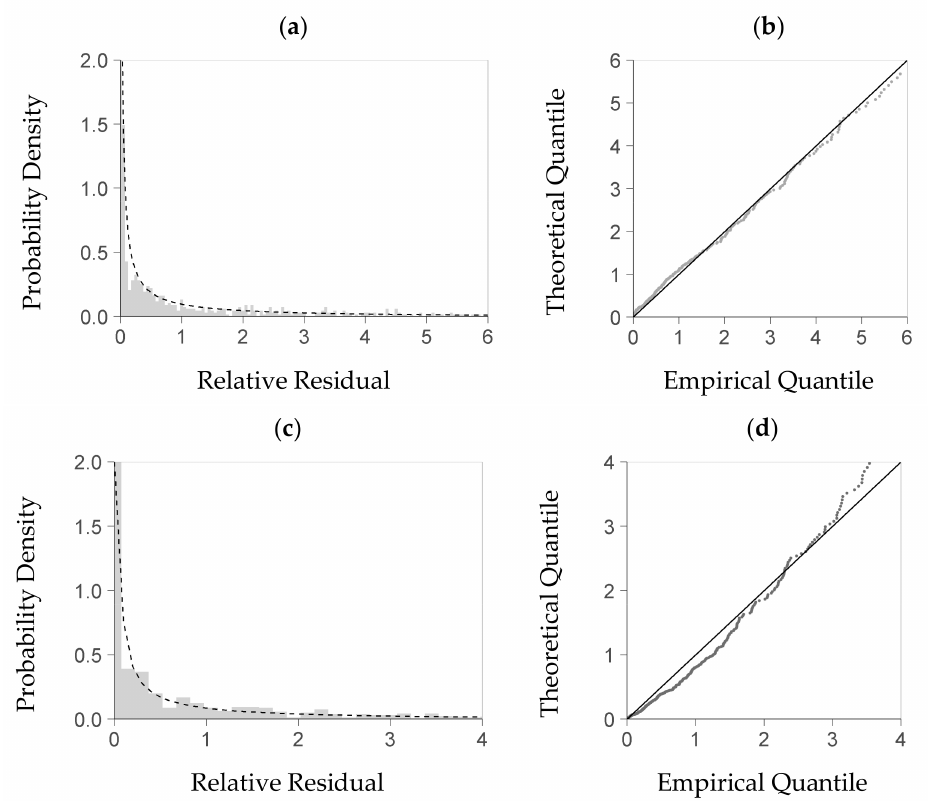
Figure 3. Plausibility test of the theoretical probability distribution that provides the basis for the stochastic part of the model (Equation (8)); diagrams ( a , b ) are based on the NFI, i.e., German National Forest Inventory; ( c , d ) are based on the BSFI, i.e., Bavarian State Forest Inventory. That distribution of relative residuals ( R in Equation (8), per-plot regeneration biomass to predicted regeneration biomass) is presented here from within a center range of the data (see Section 2.4) where the three main predictors of the deterministic model part (Figure 1), Dq , SDI , and Top Height, lie within their interquartile range each; both ( a ) (resp. ( c )) and ( b ) (resp. ( d )) compare the theoretical distribution to the empirical one; diagrams ( a ) and ( c ): probability density of the relative residual; the bars refer to the empirical density, and the line refers to the density obtained from a fitted gamma probability density function; diagrams ( b ) and ( d ): the QQ-plot of the quantile based on the fitted probability density function (Theoretical Quantile) over the quantile based on the measured data (Empirical Quantile); all shown within the 95% quantile of the relative residual (( a ), ( b ) based on 1353 NFI plots, ( c ), ( d ) based on 1069 BSFI plots used for model